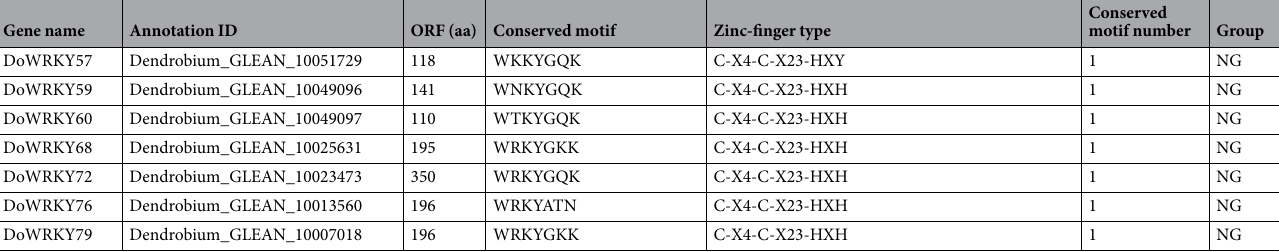
Table 1. Identified DoWRKY genes from D . officinale and their related